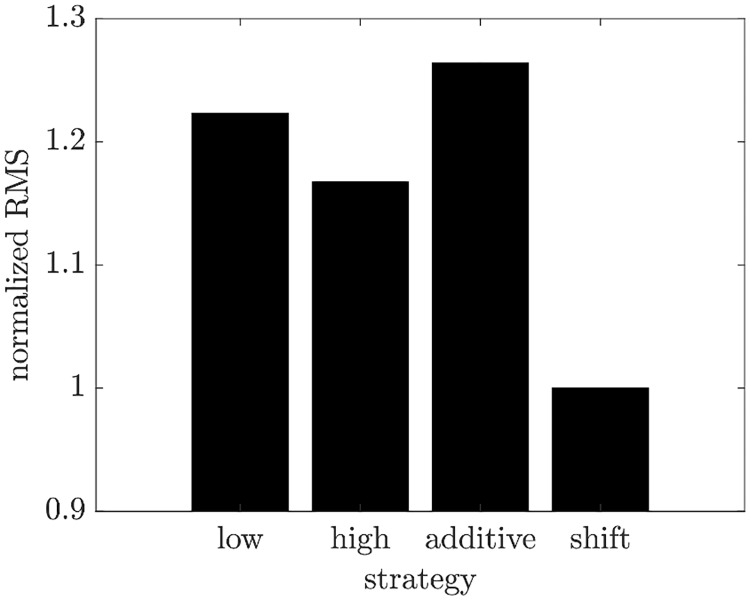
Lumped RMS values for all strategies after comparison of MGO simulations to the experimental data (Fig 5 and Fig H in S1 Text).